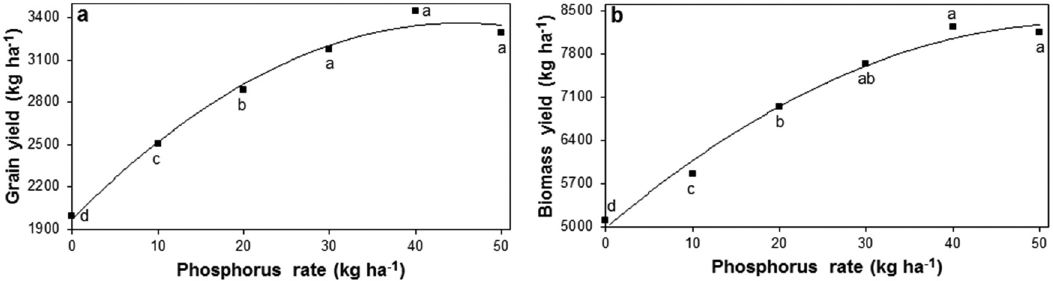
Figure 1: E ff ect of phosphorous fertilizer rate on the grain ( a ) and biomass ( b ) yields of malting barley.